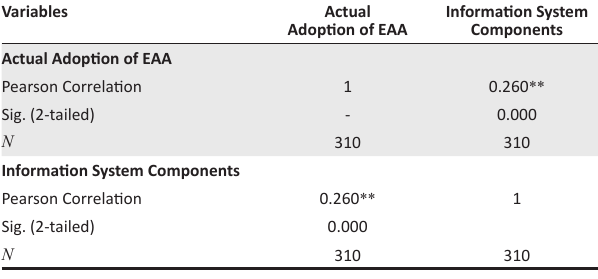
FIGURE 3: Normal distribution indicates an asymmetric distribution with acquiescent tails with a small number of outliers. The mean, median and mode are all equivalent at 24.06; σ = 3.761; N = 310. TABLE 1: Pearson Correlations.